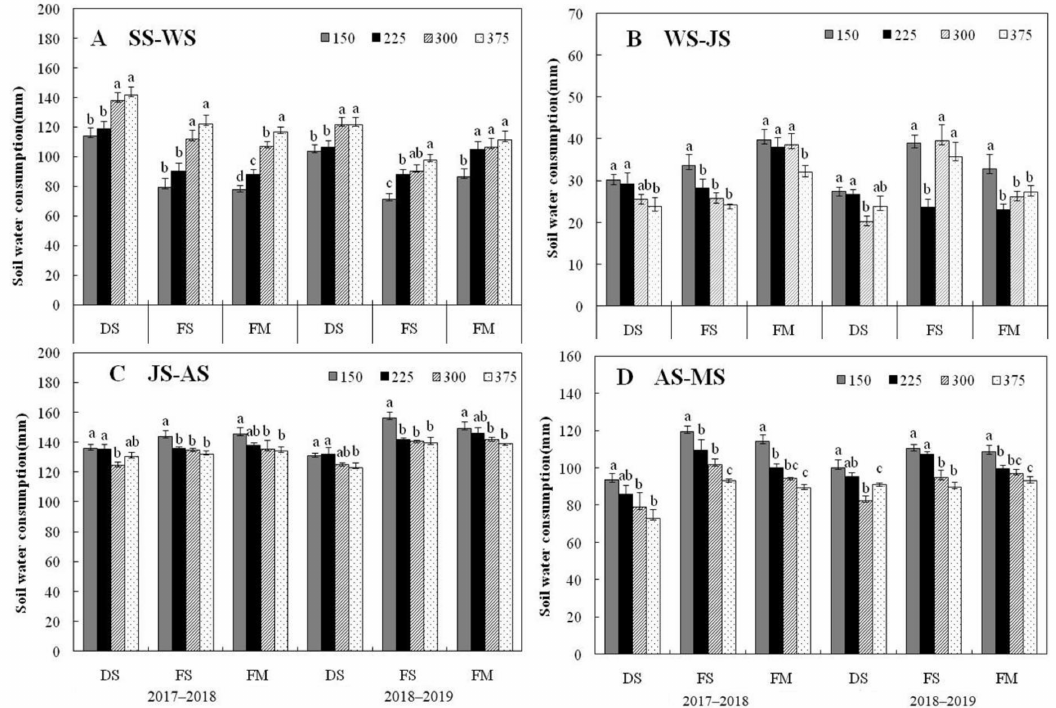
Figure 3. The difference in water consumption at the growth stages of different planting patterns and seeding rate ( A ) Soil water consumption from SS to WS. ( B ) Soil water consumption from WS to JS. ( C ) Soil water consumption from JS to AS. ( D ) Soil water consumption from AS to MS. Different small letters indicate that means within a column are significantly different ( p ≤